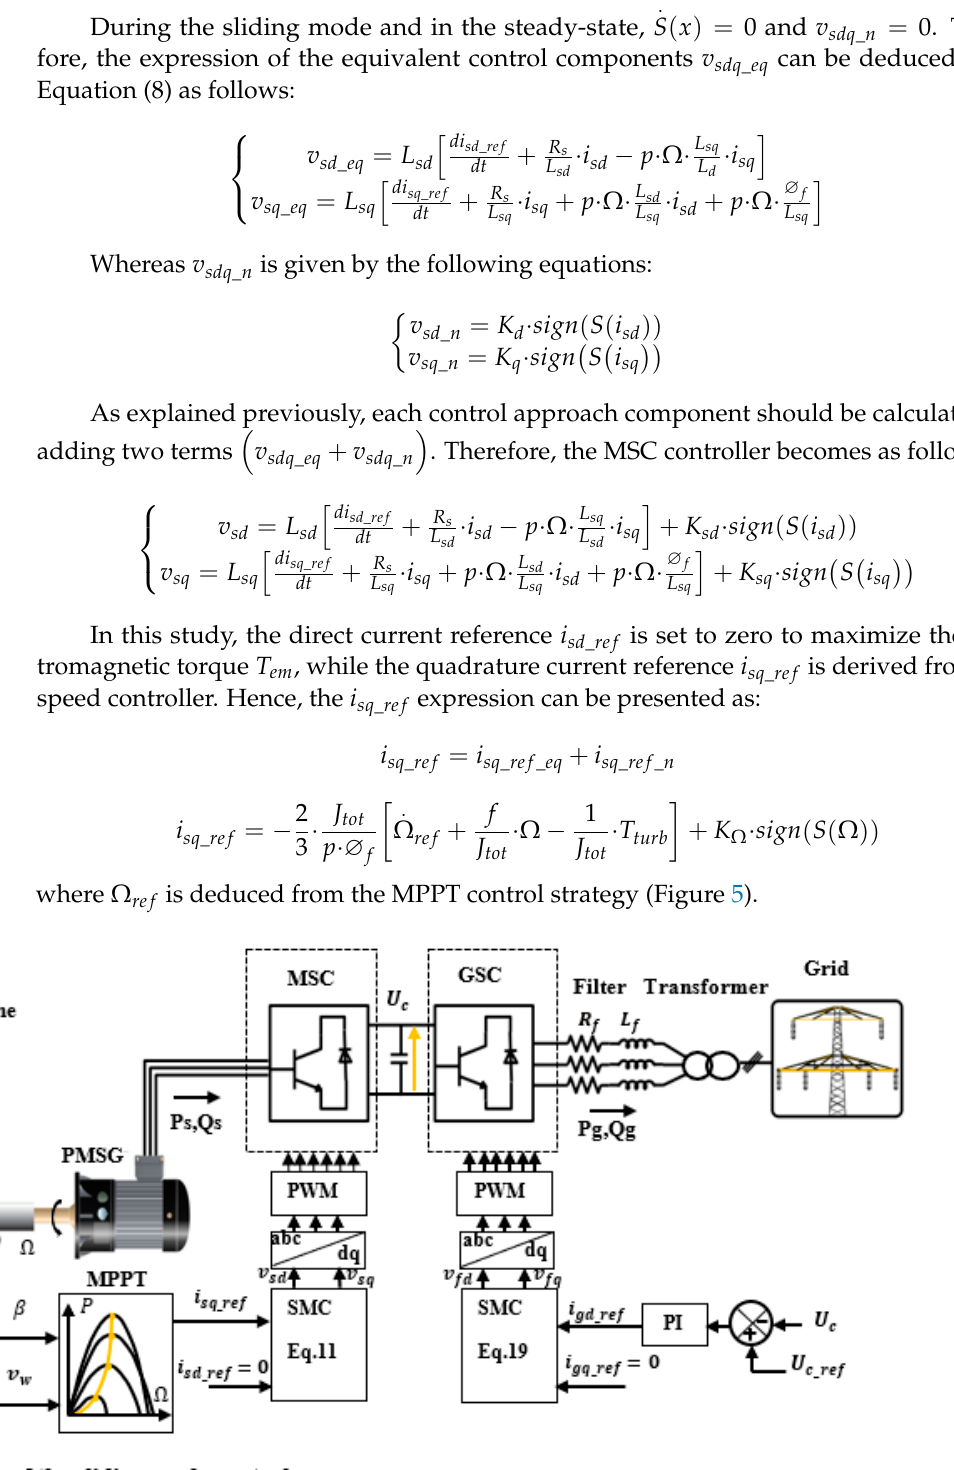
Figure 5. SMC applied to the PMSG-WECS.